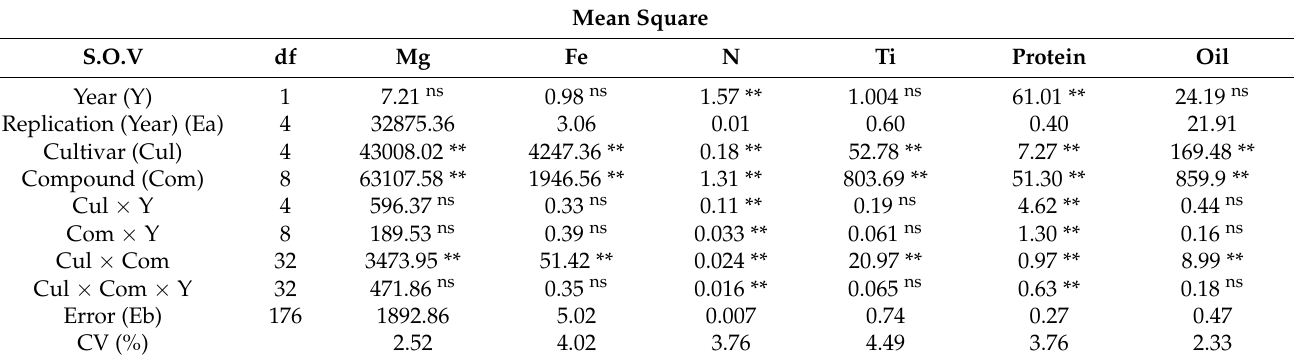
Table 8. Analysis of variance on the effects of chitosan and titanium dioxide treatments (bulk, nanoparticles) on seed mineral, protein, and oil content of five milk thistle ecotypes. Mean